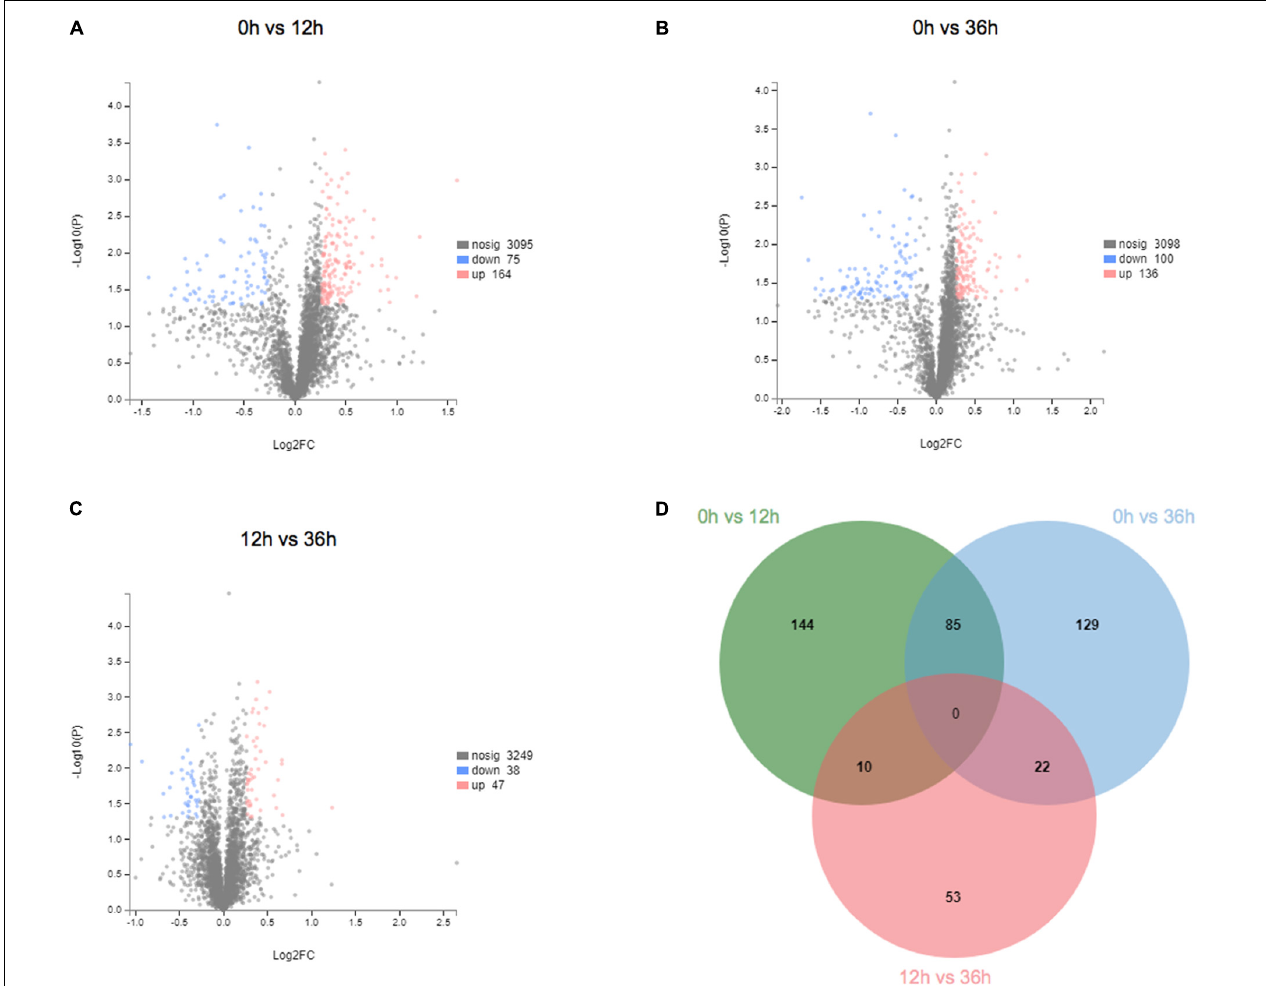
FIGURE 5 | Expression and trend of differentially expressed proteins in proteome. (A) Volcano plot of 0 vs. 12 h. (B) Volcano plot of 0 vs. 36 h. (C) Volcano plot of 12 vs. 36 h. (D) Venn diagram of differentially expressed proteins between the different groups.